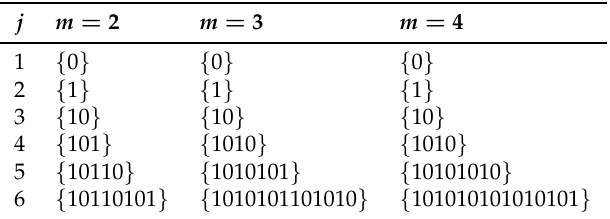
Table 2. Examples of M-bonacci binary